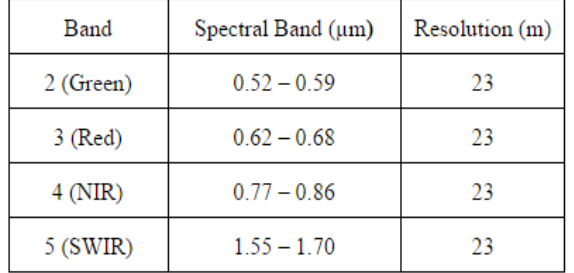
Figure 3: Characteristics of LISS-III sensor.